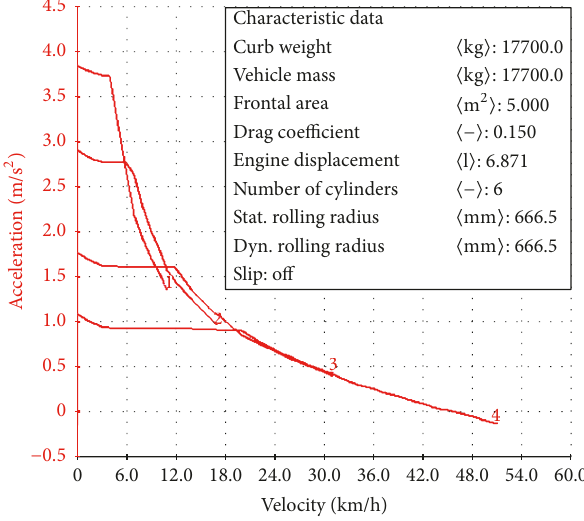
Figure 4: The acceleration and speed graph of hybrid.